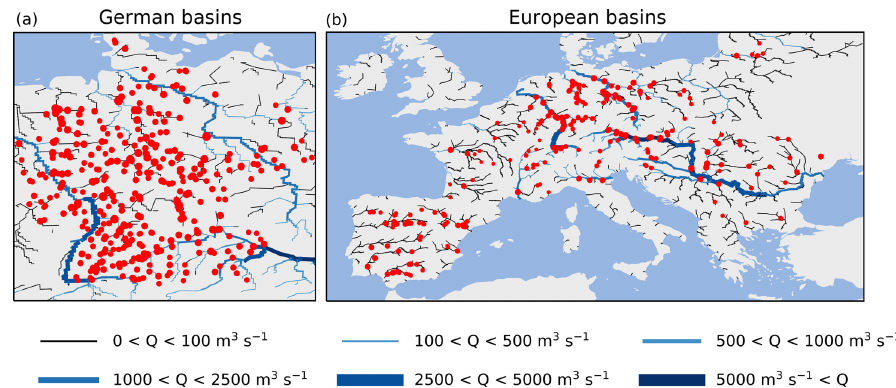
Figure 2. Discharge gauges used for the evaluation of the multiscale routing model mRM: (a) 368 gauges in the German dataset and (b) 254 gauges in the European dataset. In the background, the results of a pan-European simulation using the multiscale routing model mRM and the mesoscale hydrologic model mHM at a 5km resolution are shown. The simulated streamflow Q is depicted for 5 August